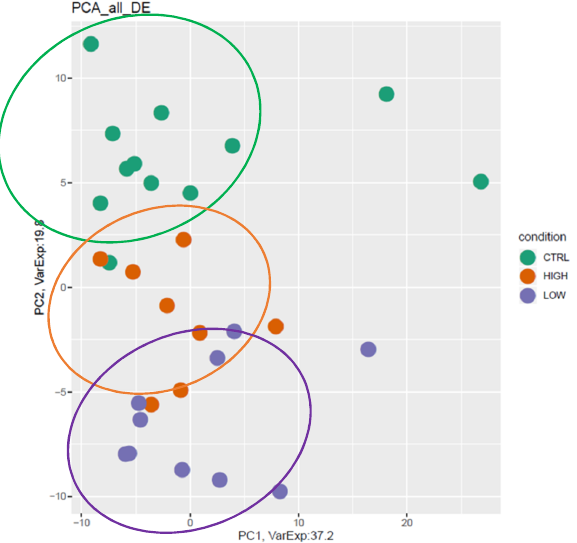
Figure 3. Principal component analysis (PCA) of all differentially expressed genes. PC1: 37.2 ( x -axis) and PC2: 19.8 ( y -axis). Both low-nSOD1 (in purple) and high-nSOD1 (in orange) groups are separate from healthy controls (CTRL in green), and interestingly, the high-nSOD1 group is closer to the control group.